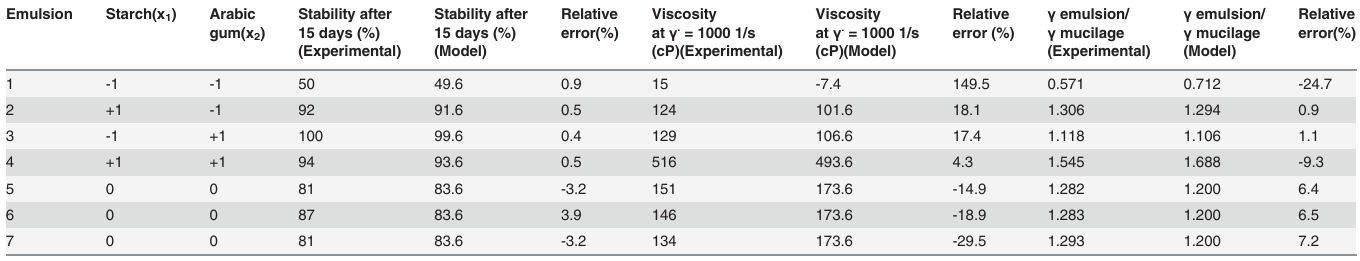
Table 6. Experimental data and predicted by the model for stability after 15 days (%), for the viscosity of the emulsions at a shear rate of 1000 1/s and for the emulsion/mucilage surface tension